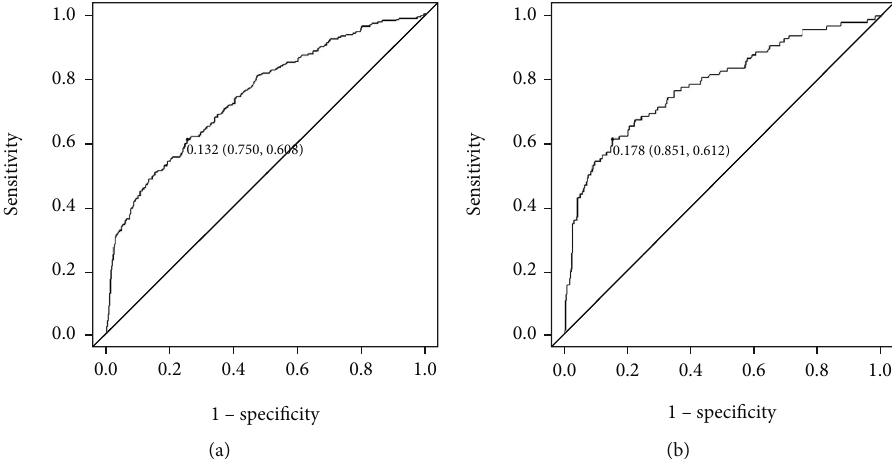
Figure 4: ROC curve of the risk prediction model for diabetic foot ulcer. (a) ROC curve of the diabetic foot ulcer risk prediction model in the primary cohort. (b) ROC curve of the diabetic foot ulcer risk prediction model in the validation